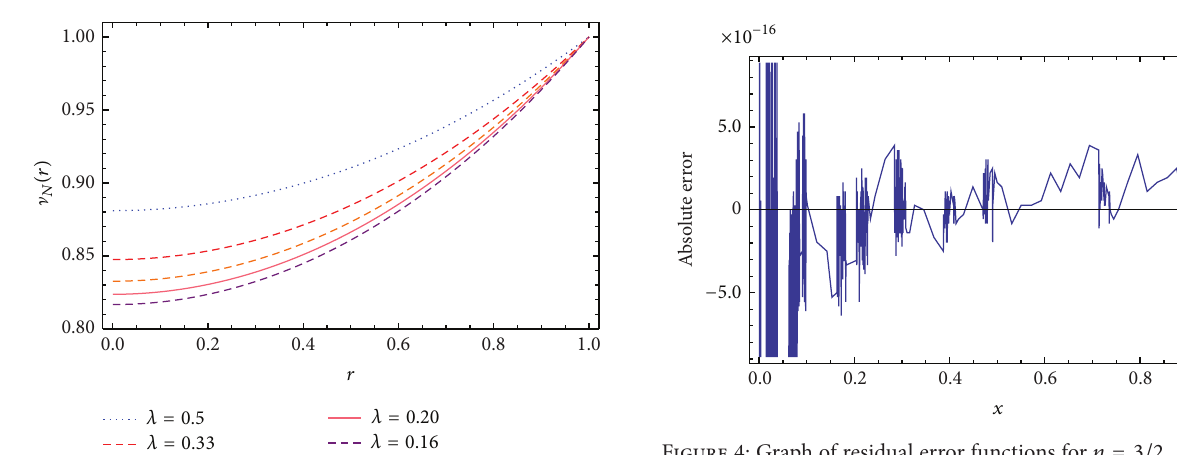
Figure 4: Graph of residual error functions for 𝑛 = 3/2 , 𝜆 = −0.5 , and 𝛼 = 𝛽 = 1 at 𝑁 = 24 .